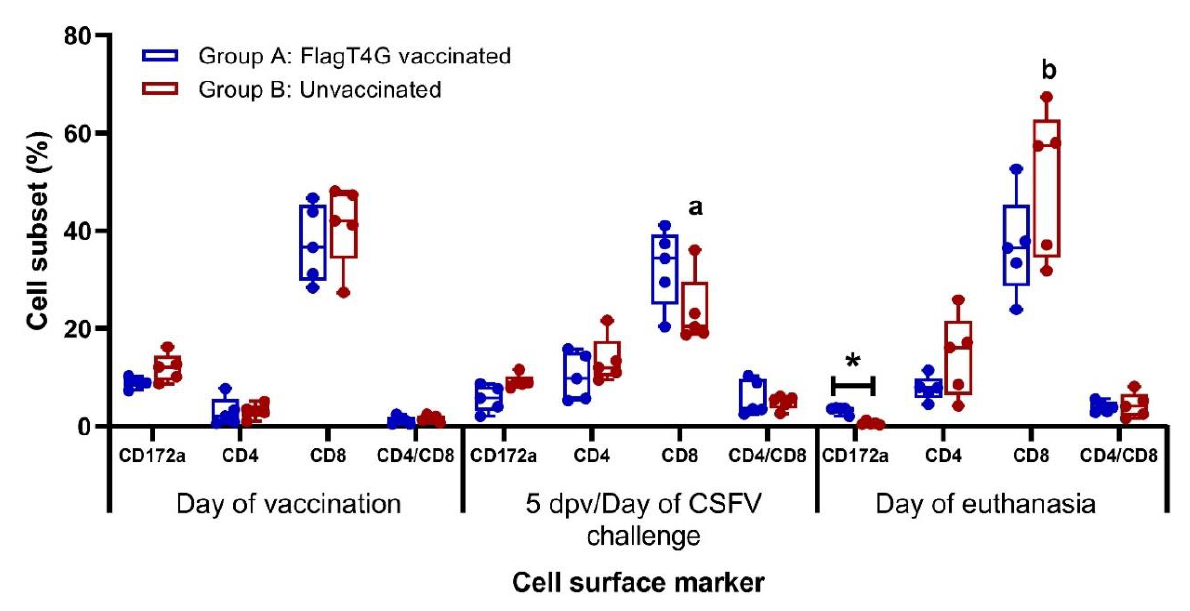
Figure 6. Immunological phenotypic profile after CSFV vaccination and challenge. Myelomonocytic and lymphocytic cell surface markers were evaluated in PBMC from vaccinated (blue boxes) and unvaccinated (red boxes) pigs. Mean values and cell subset percentages for each group at every sampling time are represented. Flow cytometry assays were carried out in duplicates. Asterisk indicates statistically significant differences between groups on that particular sampling (Kruskal– Wallis non-parametric test; p < 0.05). Differences between a given sampling and the previous one within the same group (Friedman test) are represented by the letters on top of the bar: different letters show statistical difference ( p < 0.05).